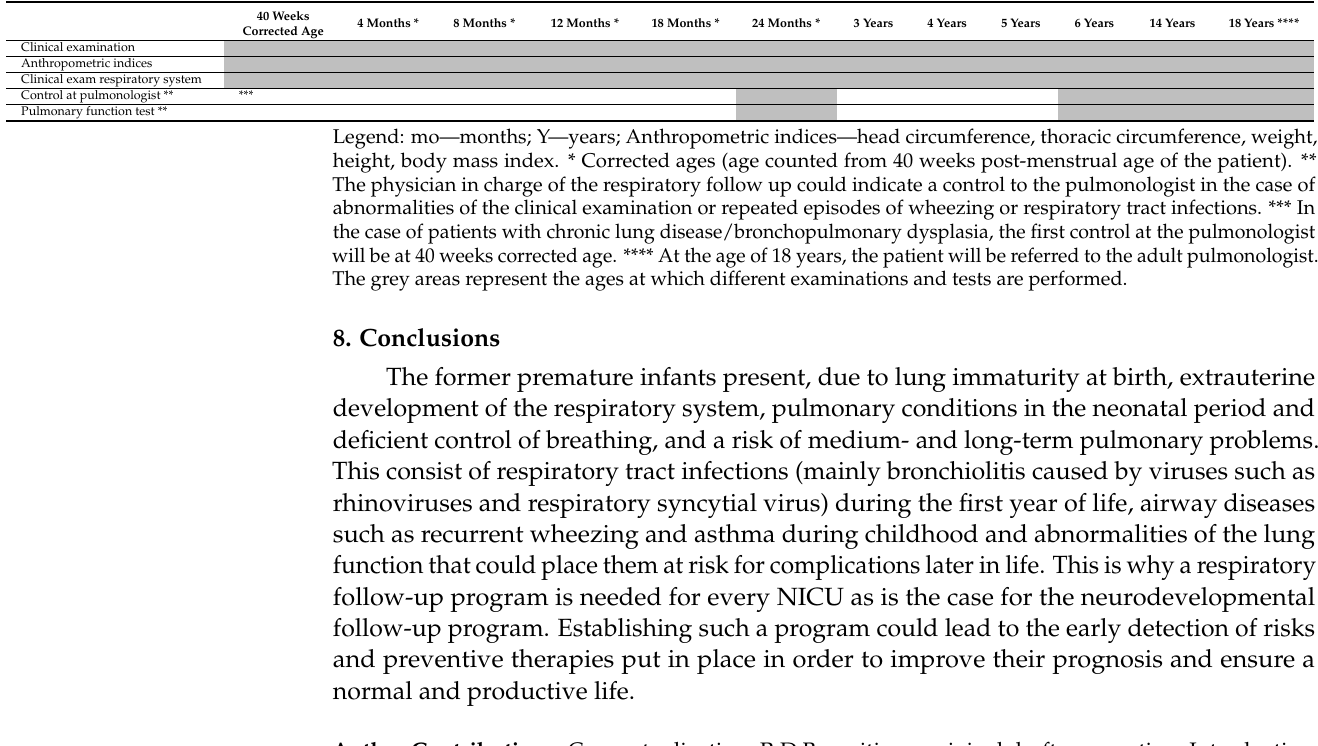
Table 4. Proposed structural frame for a respiratory follow up